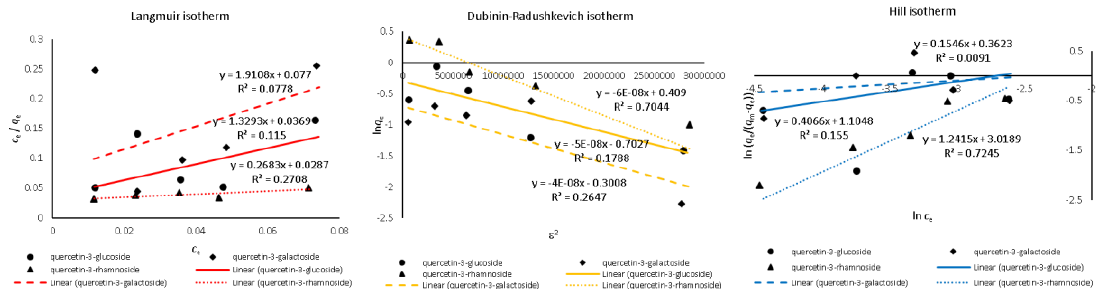
Figure 5. Langmuir, Dubinin-Radushkevich and Hill isotherms of quercetin derivatives adsorption onto β-glucan obtained with linear regression.